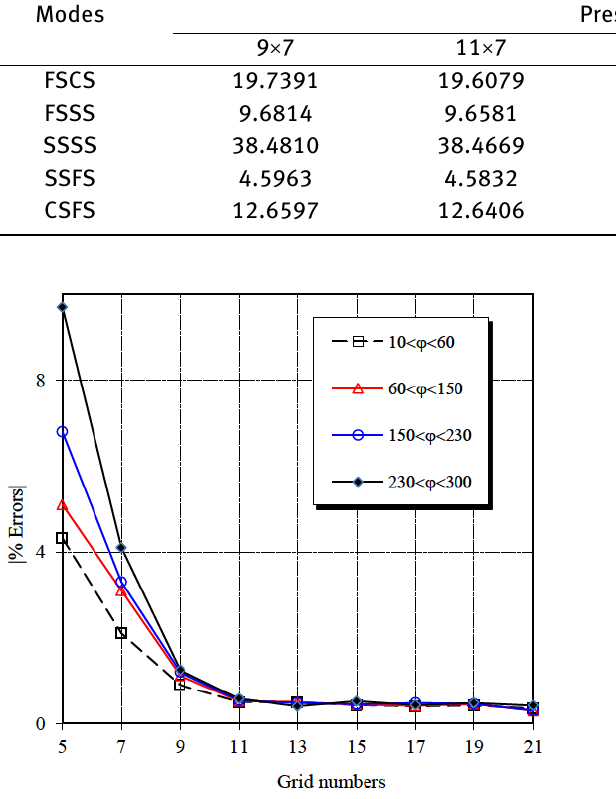
Figure 4: Variation of % errors with grid numbers for different modes and boundary conditions of annular sector plate ( ϕ =150 0 )